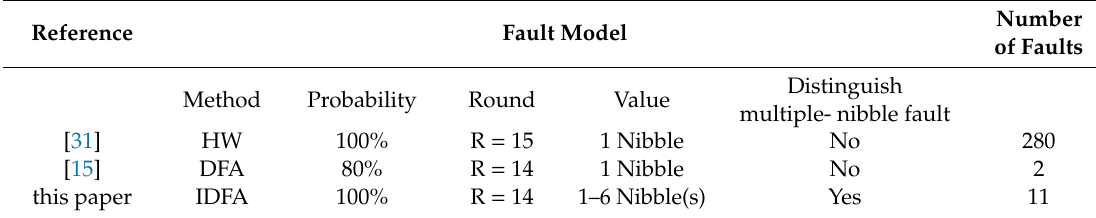
Table 1. Comparison of this work with previous fault attacks on Midori ‐ 64.